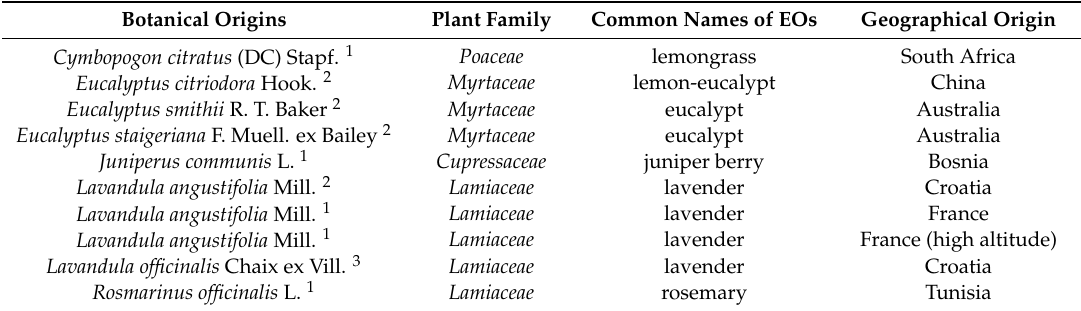
Table 1. Origins data of essential oils (EOs) from aerial parts of different plant